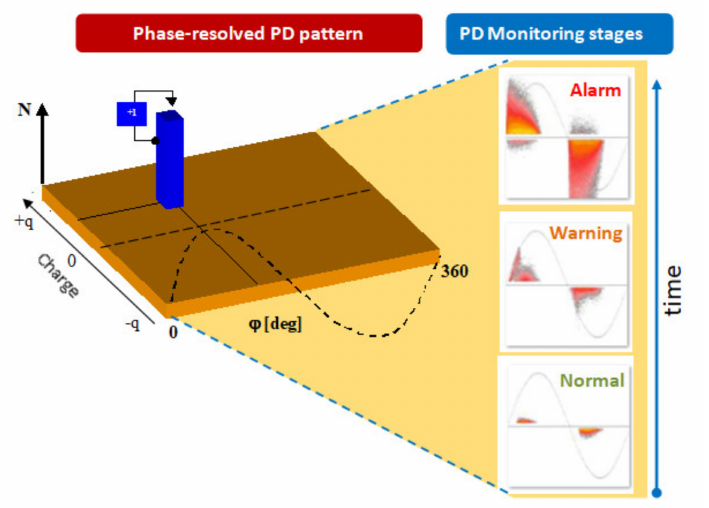
Figure 1. Visualization of partial discharge phase-resolved methodology along with exemplary monitoring